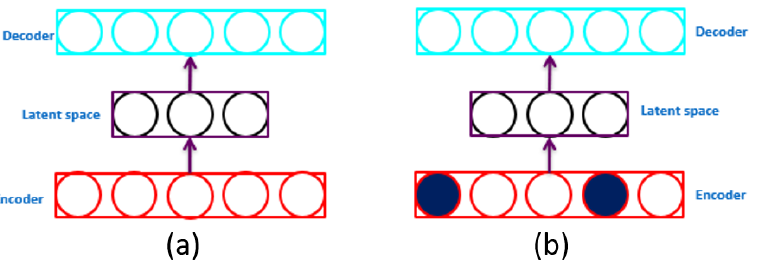
Figure 11. A pictorial representation of ( a ) an Autoencoder and ( b ) a Denoising Autoencoder. An autoencoder is trained to reconstruct its input, while a denoising autoencoder is trained to reconstruct a “clean” version of its input from a corrupted or “noisy” version of the